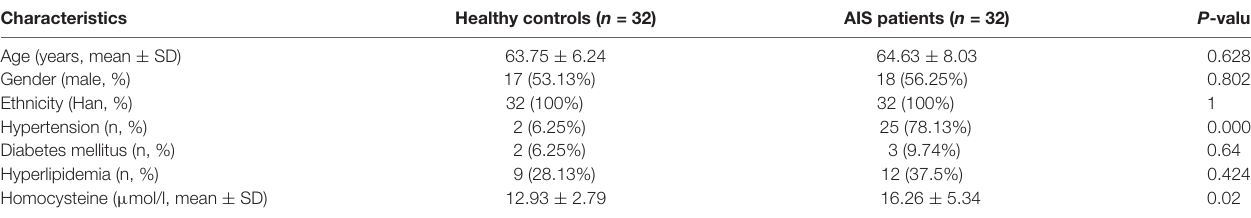
TABLE 1 | Clinical characteristics of the studied subjects. Characteristics